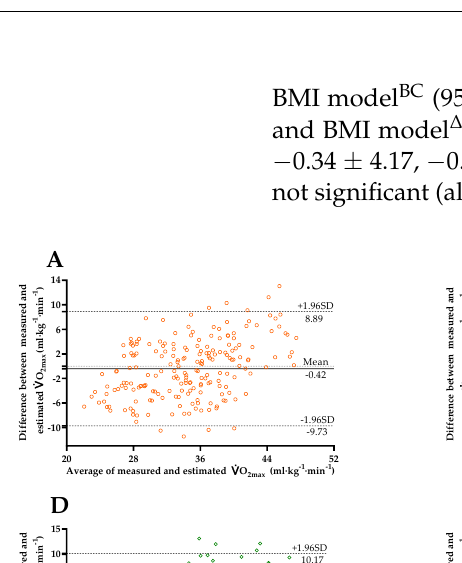
. • VO 2max in the entire sample O 2max in the entire sample